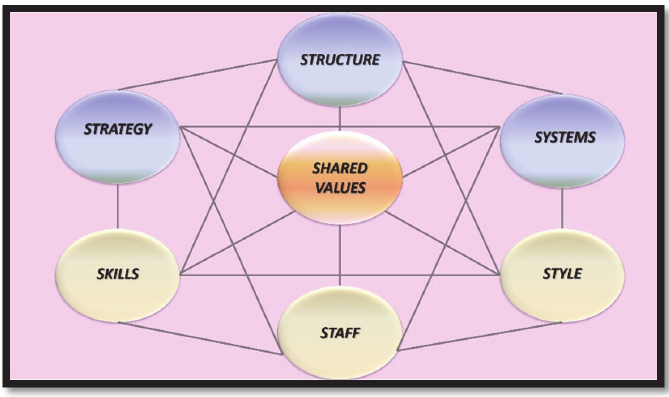
Fig. 2. The McKinsey 7S’s framework – key organization capabilities needed to implement strategy successfully (Adapted from Singh,